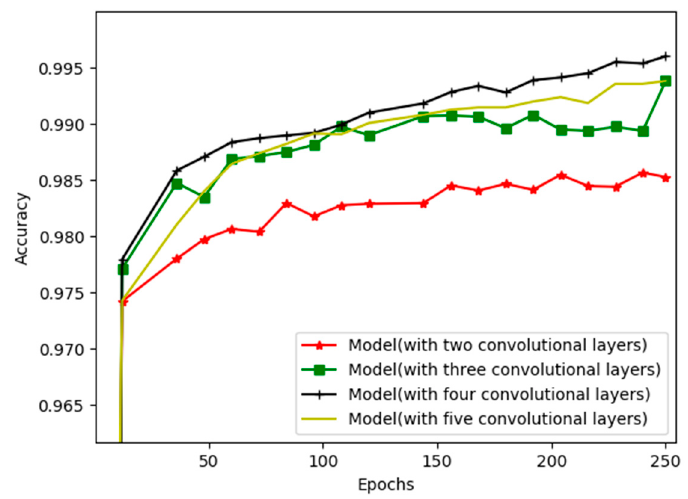
Figure 6. Comparison of the models with two, three, and four layers, respectively.